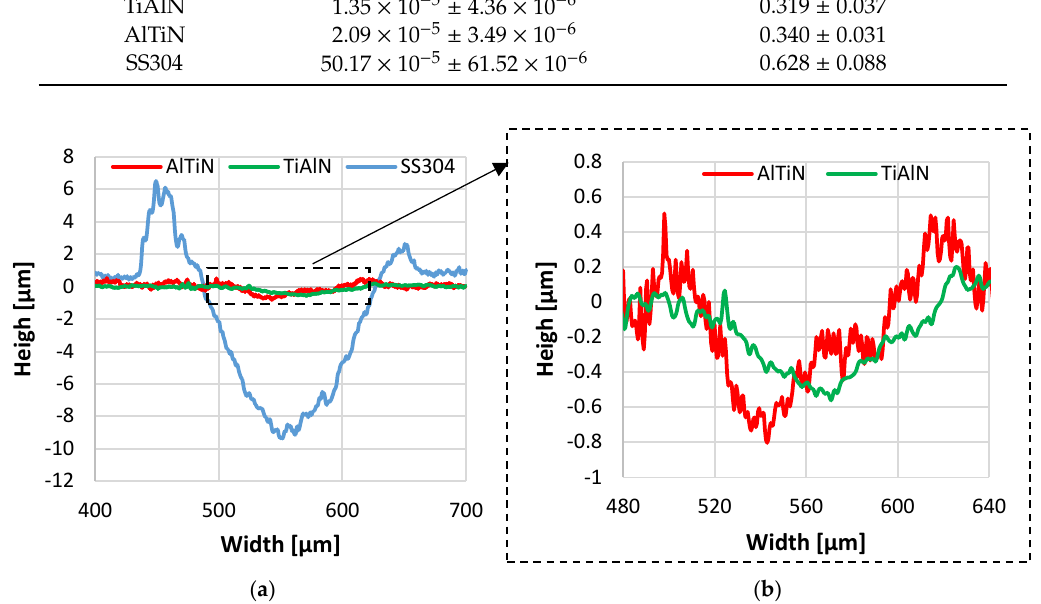
Table 4. Sliding wear results of the films and reference SS304 sample (mean ± SD). Sample